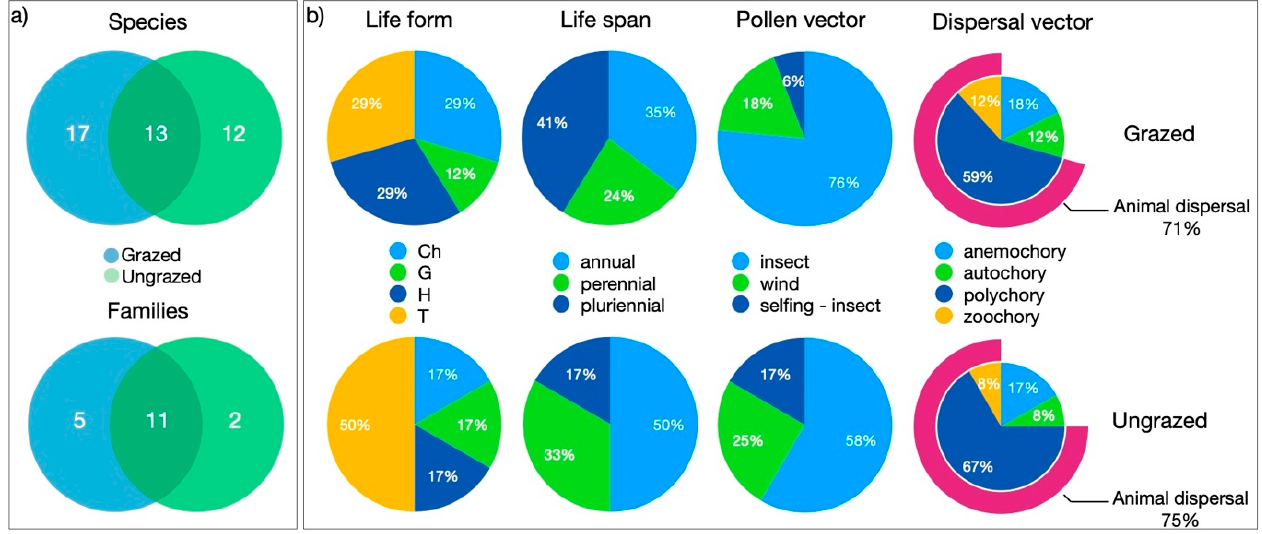
Figure 4. Floristic analysis. ( a ) Symmetric Venn diagrams of shared and exclusive plant species and families of grazed and ungrazed grassland plots. ( b ) Comparison of functional traits of species exclusive to grazed plots (top) and ungrazed plots (bottom); pie sections represent frequency of occurrence (%) of traits for each category. For dispersal, the percentage of species represented by animal dispersal includes exclusively zoochorous as well as polychorous species. Table 2. Functional traits considered and frequency of occurrence (%) in grazed and ungrazed plots. Trait